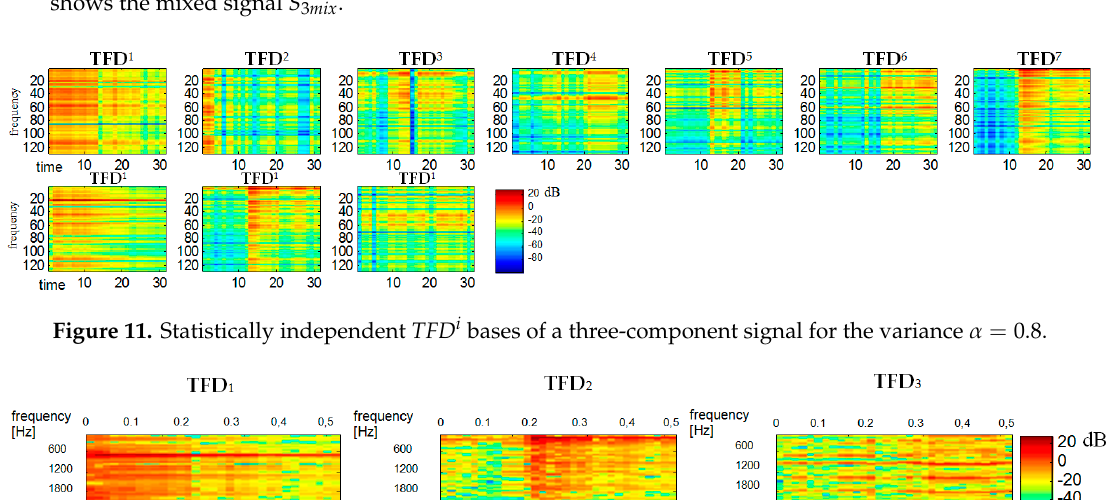
Figure 10. Spectrograms of constituent signals: S 1 —ringer, S 2 —baby, S 3 —tom. The bottom spectrogram shows the mixed signal S 3 mix . Sensors 2020 , 20 , 2019